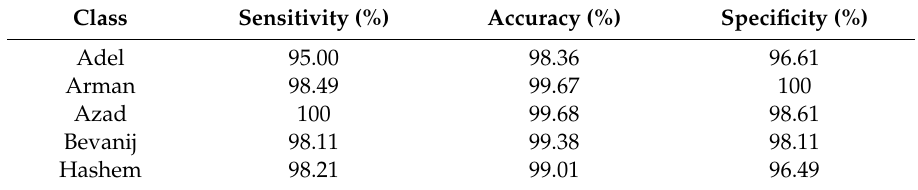
Table 6. Performance criteria related to the confusion matrix using the feature-based approach. Class